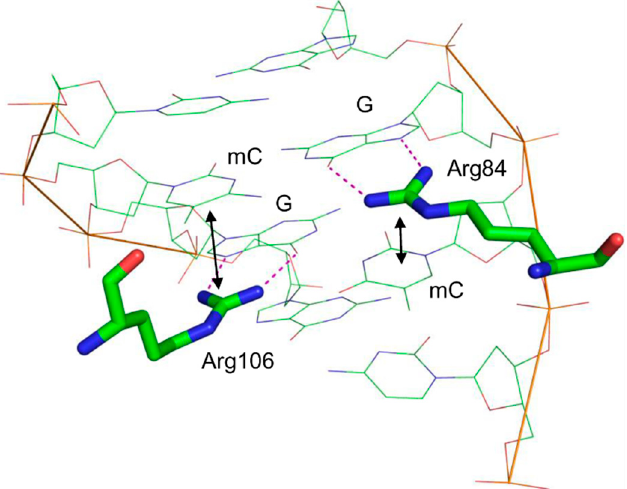
Figure 5. Structure of the mouse MBD4 methyl-binding domain bound to a fully methylated CpG site in DNA (PDB ID 3VXV [165] ). Dotted lines indicate the hydrogen bonds formed between G and the critical Arg residues; double-headed arrows show stacking between these arginines and mC.